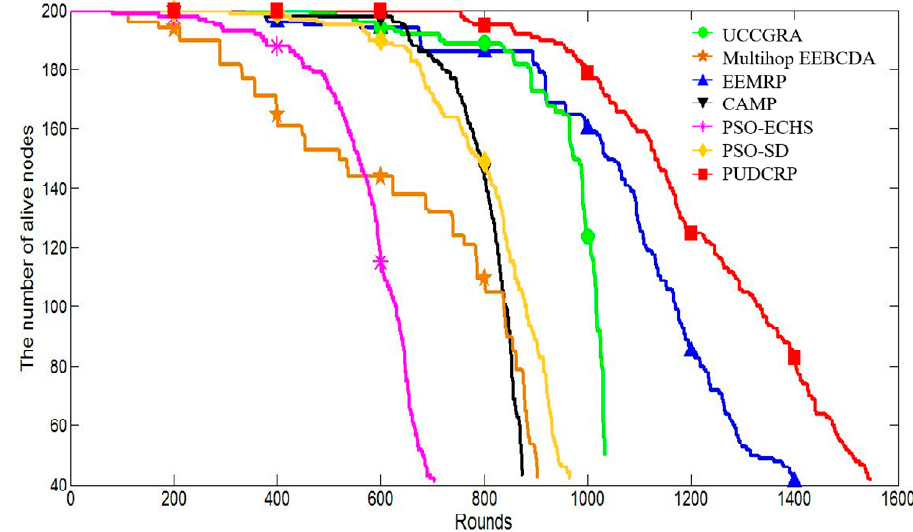
Figure 16. The number of surviving nodes in the 400 m × 400 m network area.